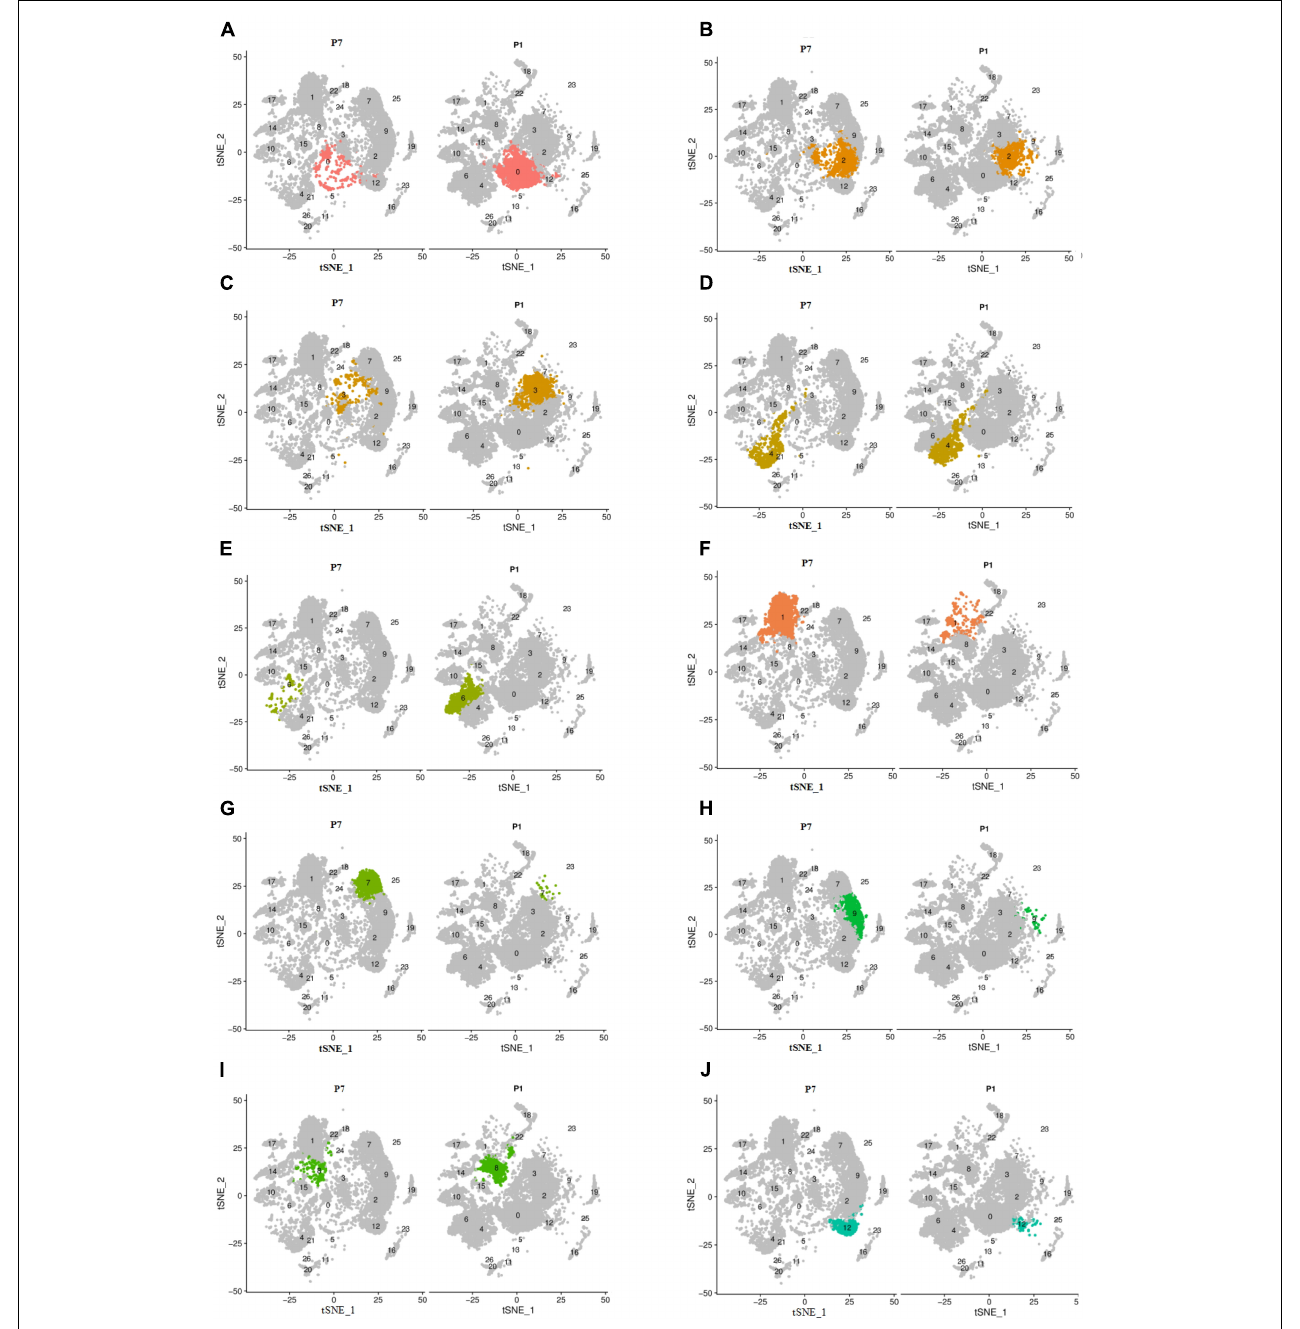
FIGURE 3 | The change of cell number of the above different cell clusters in two different periods of P1 and P7. Cells were clustered using a graph-based shared nearest-neighbor clustering approach plotted by a tSNE plot. (A,C–E,I) The decreased clusters of 0, 3, 4, 6, and 8. (B,F–H,J) The significantly increased clusters of 1, 7, 9, and